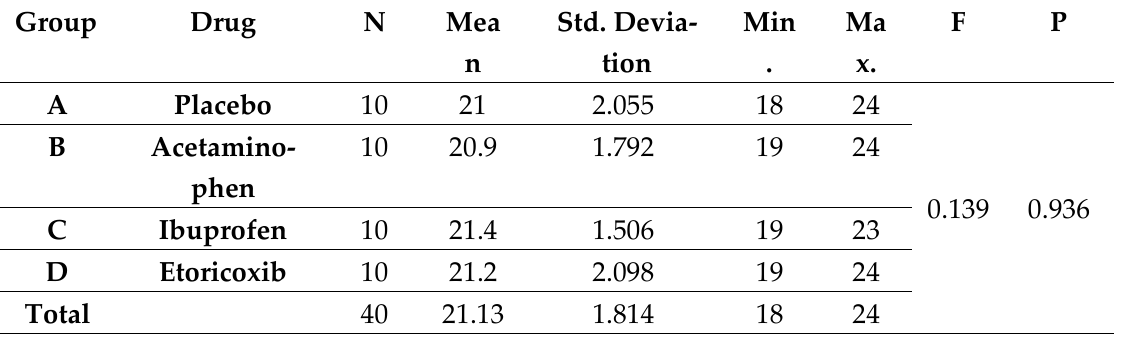
Table 1 Descriptive statistics and distribution of age in the study